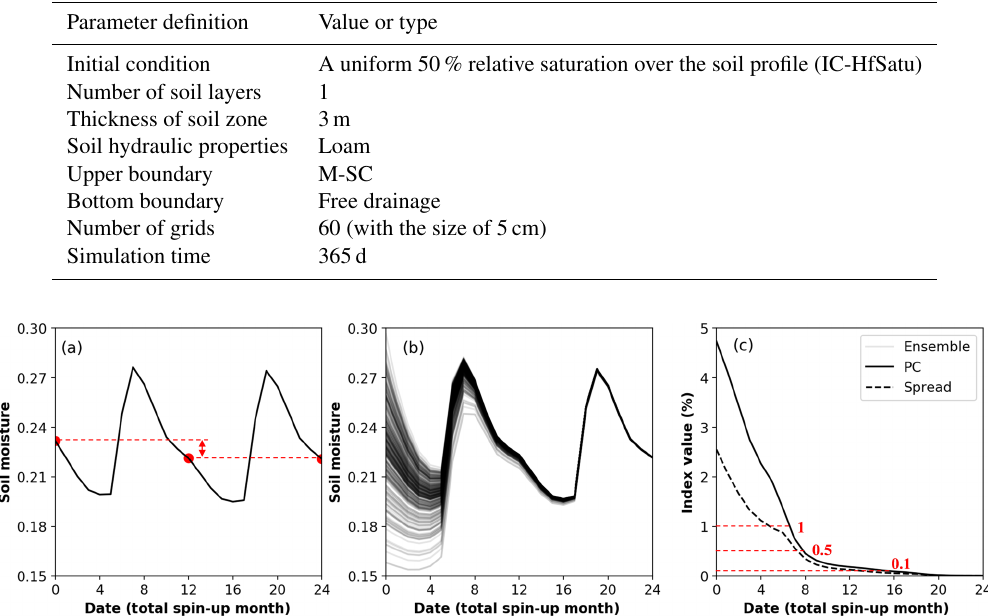
Table 2. The default model settings used in the simulations.